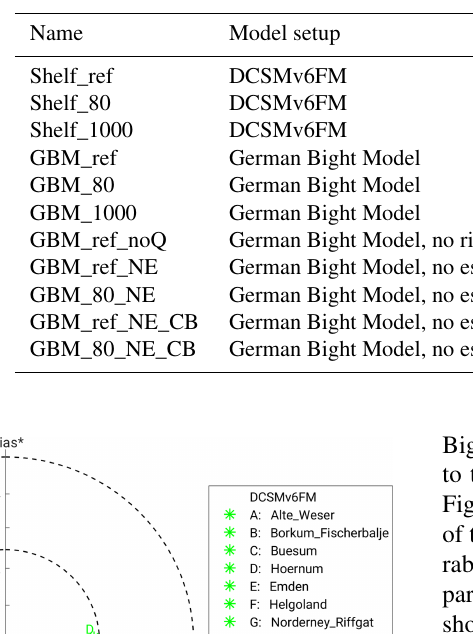
Table 2. Overview of model simulations undertaken.